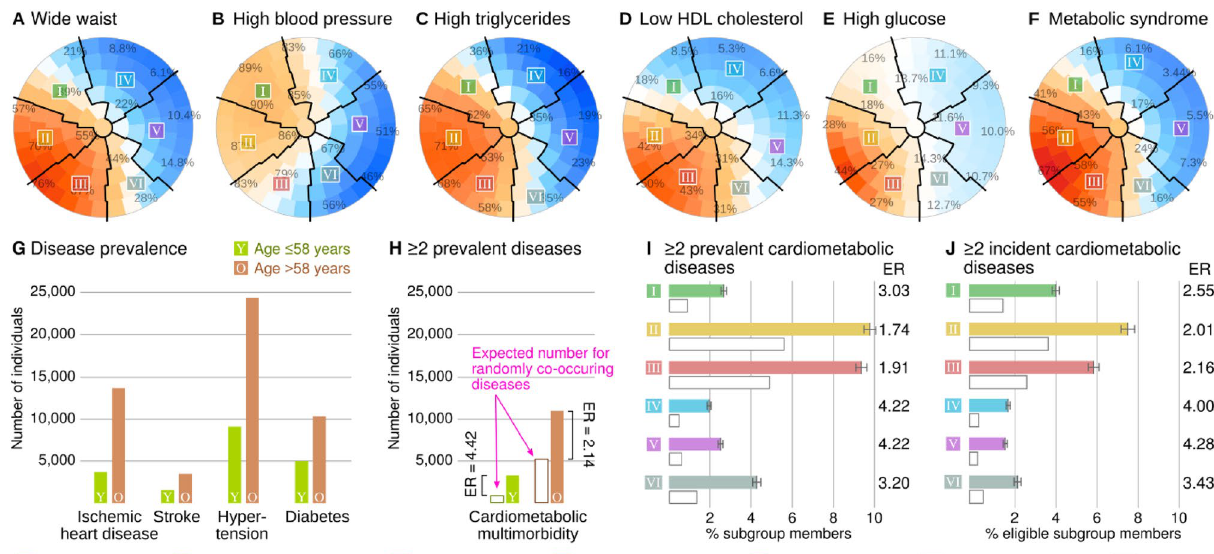
Figure 6. The metabolic syndrome (MetS) and multimorbidity. MetS was defined according to the NCEP ATP III criteria that include five components ( A–E , the percentages in the plots indicate the proportion of individuals that satisfy a criterion) and subsequent binary classification for those with ≥ 3 points ( F ). The participants were divided into those with age ≤ 58 ( N = 167,337 or 50.7%) and those with age > 58 ( N = 162,571 or 49.3%) to create two equally sized age strata ( G ). The null model represents the number of multimorbid cases if the co-occurrence of diseases was random. Bars for subgroups include 95% confidence intervals ( H–J